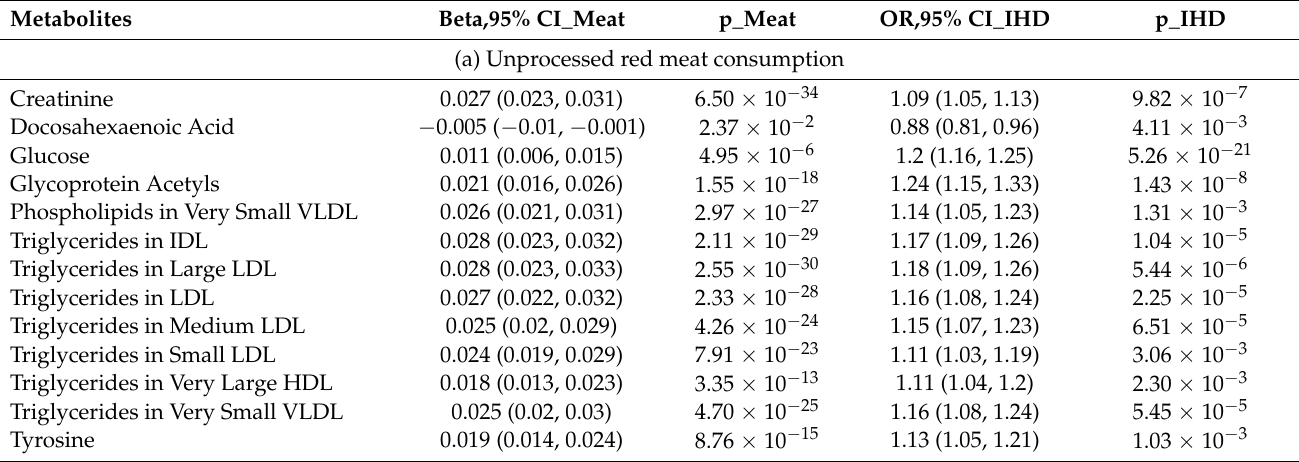
Table 2. Overall association of metabolic biomarkers with red meat and with